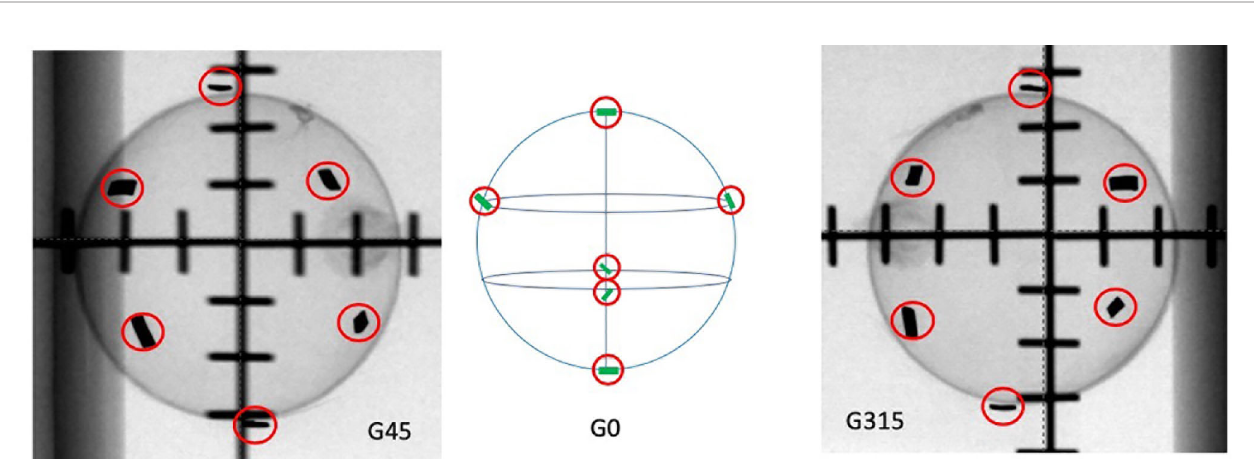
FIGURE 1 | The tested ideal FM con fi gurations. G45 represents the 45° oblique view. G0 is the graphical illustration of how the FMs are ideally distributed on the surface of a sphere. G315 represents the 315° oblique